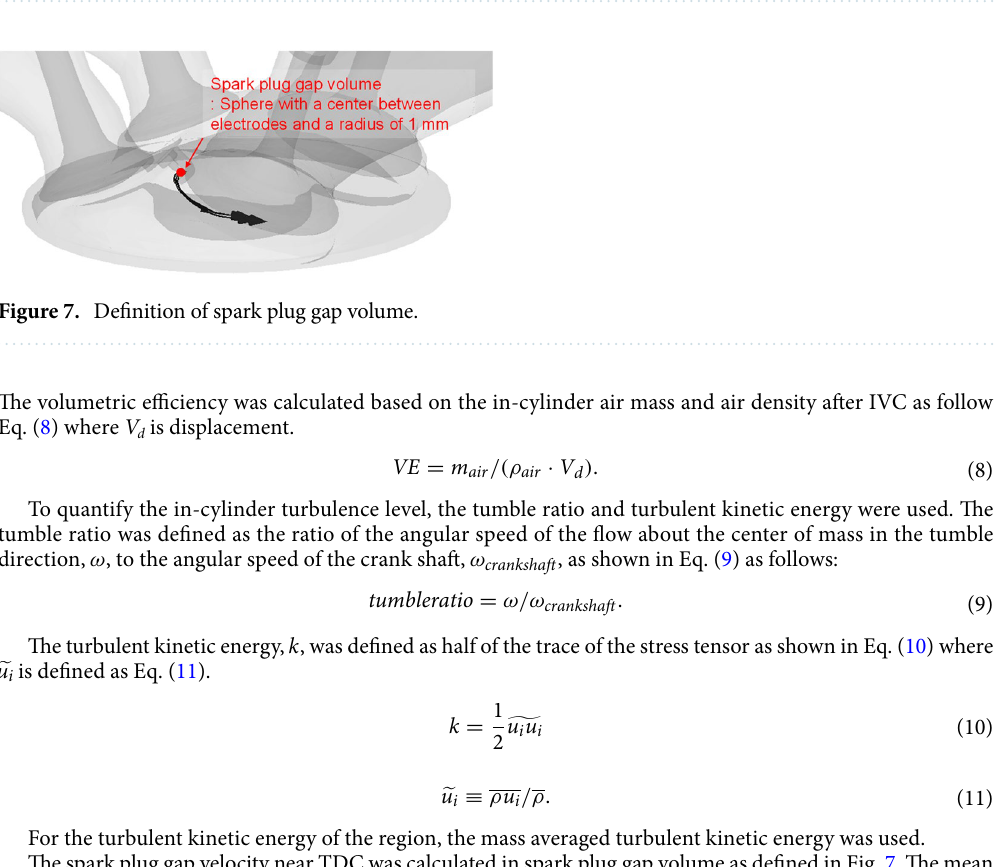
Figure 6. Intake manifold geometry for evaluating the effect of intake manifold curve radius.